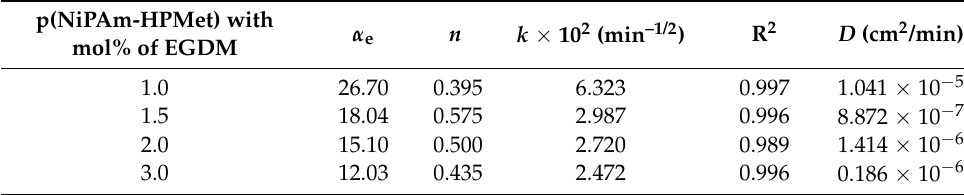
Table 3. The equilibrium swelling ratio ( α e ) and kinetic parameters ( n , k and D ) of the fluid diffusion into p(NiPAm-HPMet) hydrogels at 10 ◦ C and pH 7.4.